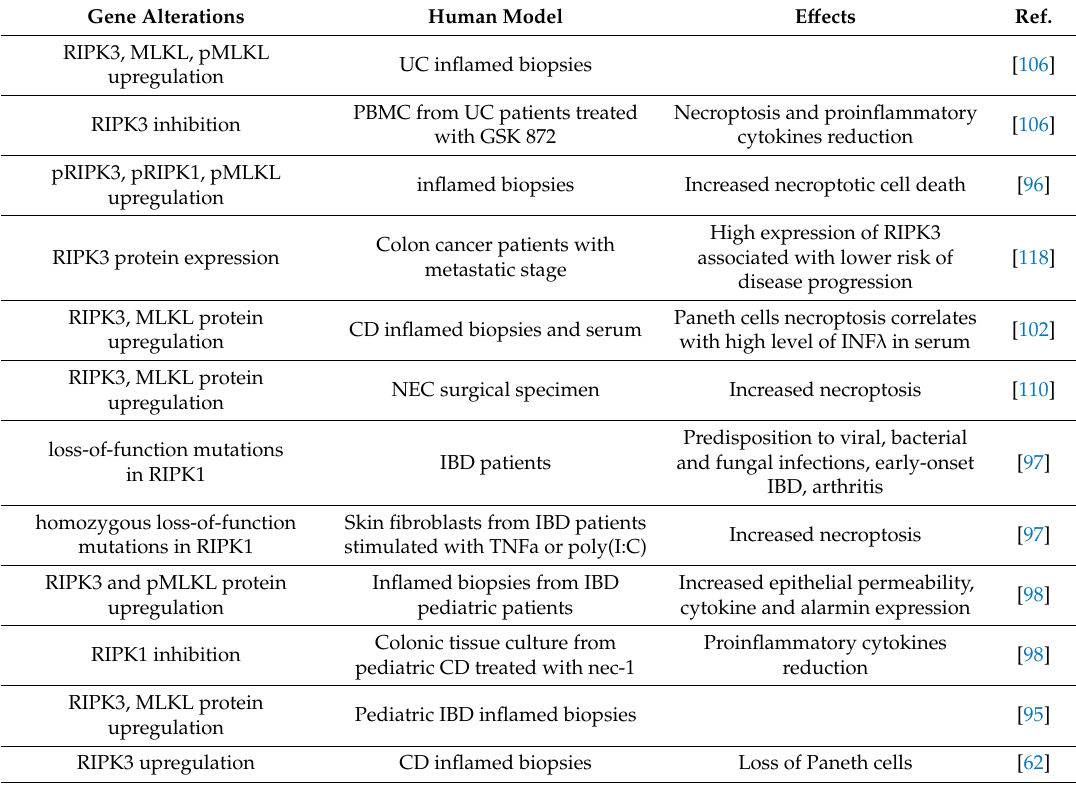
Table 1. Alterations of necroptotic genes in human intestinal diseases. IBD, inflammatory bowel disease; UC, ulcerative colitis; CD, Crohn’s disease; NEC, necrotizing enterocolitis; pMLKL,